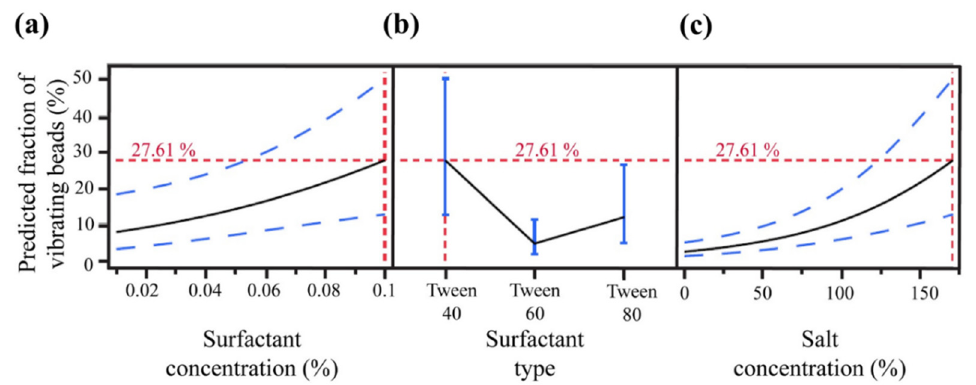
Figure 3. Prediction profiler for evaluating the optimal working buffer composition modeled on: ( a ) surfactant concentration; ( b ) surfactant type; and ( c ) salt concentration. The dotted blue and red lines indicate the confidence interval and maximum predicted fraction of vibrating MBs, respectively.